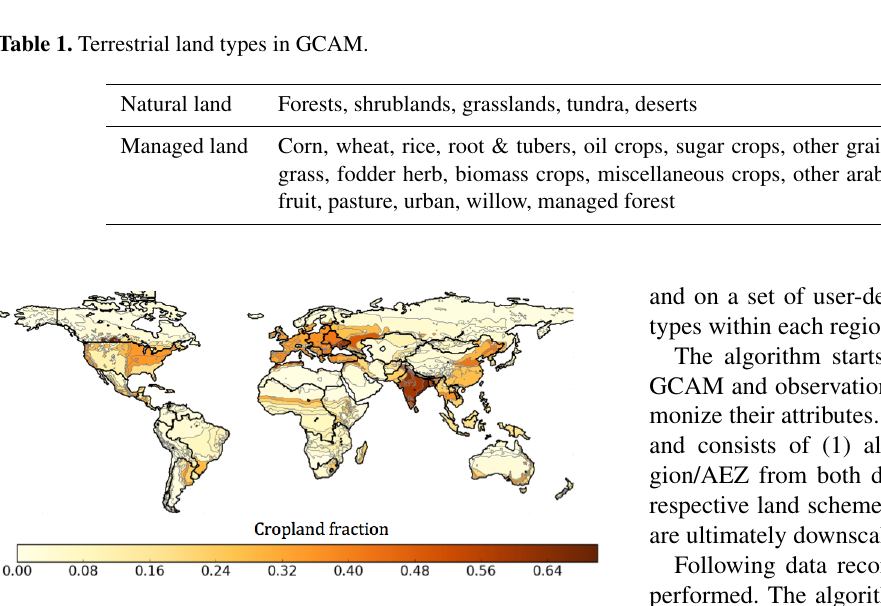
Figure 2. Distribution of 2005 GCAM croplands at the region/AEZ scale. The algorithm presented in this paper downscales these pat- terns to a gridded scale (Figs. 5 and